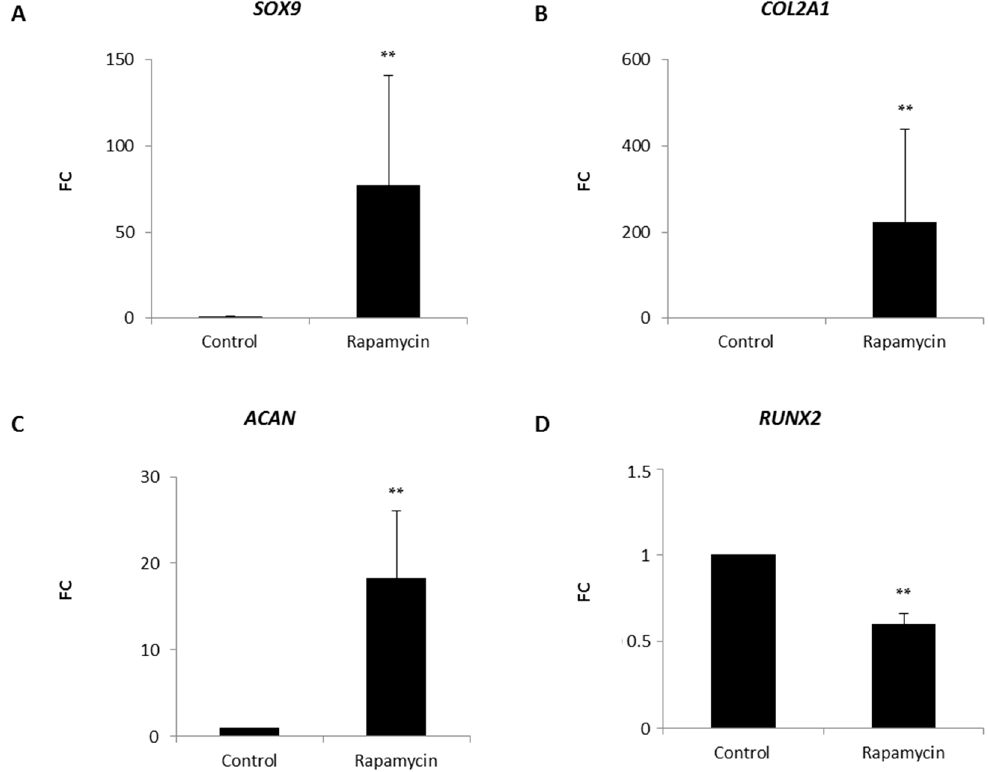
Figure 2. Effect of mTORC1 inhibition on the chondrogenic gene expression of patient-derived OA chondrocytes. Collagen type I-chondrocyte constructs were cultured in chondrogenic culture media supplemented without (control) with or rapamycin for 14 days. mRNA was isolated and quantitative real time polymerase chain reaction (RT-PCR) was performed: for the main chondrogenic markers SRY-box ( SOX ) 9 , collagen type II α 1 chain ( COL2A1 ) and aggrecan ( ACAN ) ( A – C ); and for the hypertrophic marker RUNX2 ; ( D ) Experiments were performed in triplicates and results are shown as relative gene expression ± standard error of the mean (SEM) versus control. p < 0.01 was considered highly significant (**).